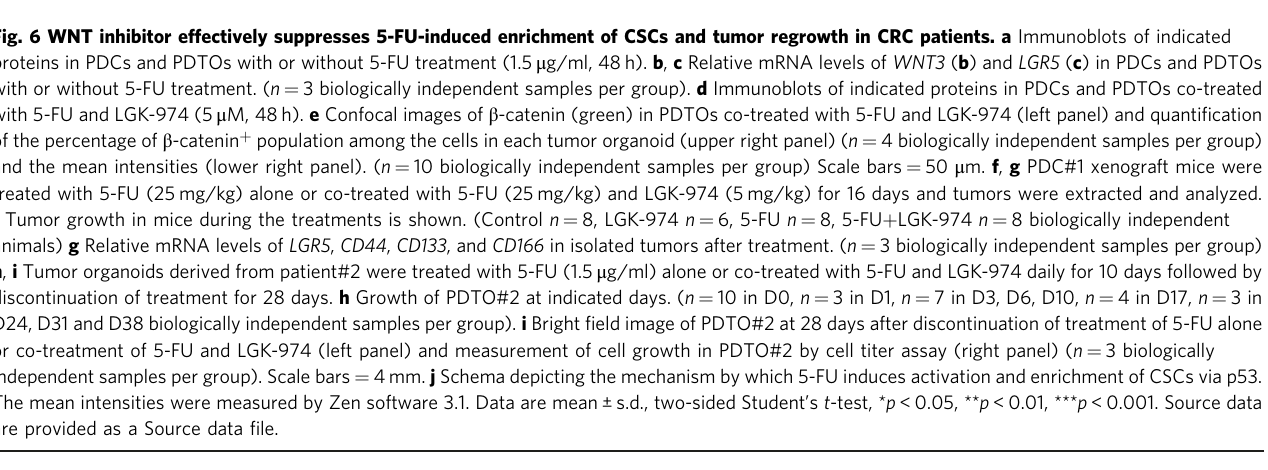
Fig. 6 WNT inhibitor effectively suppresses 5-FU-induced enrichment of CSCs and tumor regrowth in CRC patients. a Immunoblots of indicated proteins in PDCs and PDTOs with or without 5-FU treatment (1.5 μ g/ml, 48 h). b , c Relative mRNA levels of WNT3 ( b ) and LGR5 ( c ) in PDCs and PDTOs with or without 5-FU treatment. ( n = 3 biologically independent samples per group). d Immunoblots of indicated proteins in PDCs and PDTOs co-treated with 5-FU and LGK-974 (5 μ M, 48 h). e Confocal images of β -catenin (green) in PDTOs co-treated with 5-FU and LGK-974 (left panel) and quanti fi cation of the percentage of β -catenin + population among the cells in each tumor organoid (upper right panel) ( n = 4 biologically independent samples per group) and the mean intensities (lower right panel). ( n = 10 biologically independent samples per group) Scale bars = 50 μ m. f , g PDC#1 xenograft mice were treated with 5-FU (25 mg/kg) alone or co-treated with 5-FU (25 mg/kg) and LGK-974 (5 mg/kg) for 16 days and tumors were extracted and analyzed. f Tumor growth in mice during the treatments is shown. (Control n = 8, LGK-974 n = 6, 5-FU n = 8, 5-FU + LGK-974 n = 8 biologically independent animals) g Relative mRNA levels of LGR5 , CD44 , CD133 , and CD166 in isolated tumors after treatment. ( n = 3 biologically independent samples per group) h , i Tumor organoids derived from patient#2 were treated with 5-FU (1.5 μ g/ml) alone or co-treated with 5-FU and LGK-974 daily for 10 days followed by discontinuation of treatment for 28 days. h Growth of PDTO#2 at indicated days. ( n = 10 in D0, n = 3 in D1, n = 7 in D3, D6, D10, n = 4 in D17, n = 3 in D24, D31 and D38 biologically independent samples per group). i Bright fi eld image of PDTO#2 at 28 days after discontinuation of treatment of 5-FU alone or co-treatment of 5-FU and LGK-974 (left panel) and measurement of cell growth in PDTO#2 by cell titer assay (right panel) ( n = 3 biologically independent samples per group). Scale bars = 4 mm. j Schema depicting the mechanism by which 5-FU induces activation and enrichment of CSCs via p53. The mean intensities were measured by Zen software 3.1. Data are mean ± s.d., two-sided Student ’ s t -test, * p < 0.05, ** p < 0.01, *** p < 0.001. Source data are provided as a Source data fi